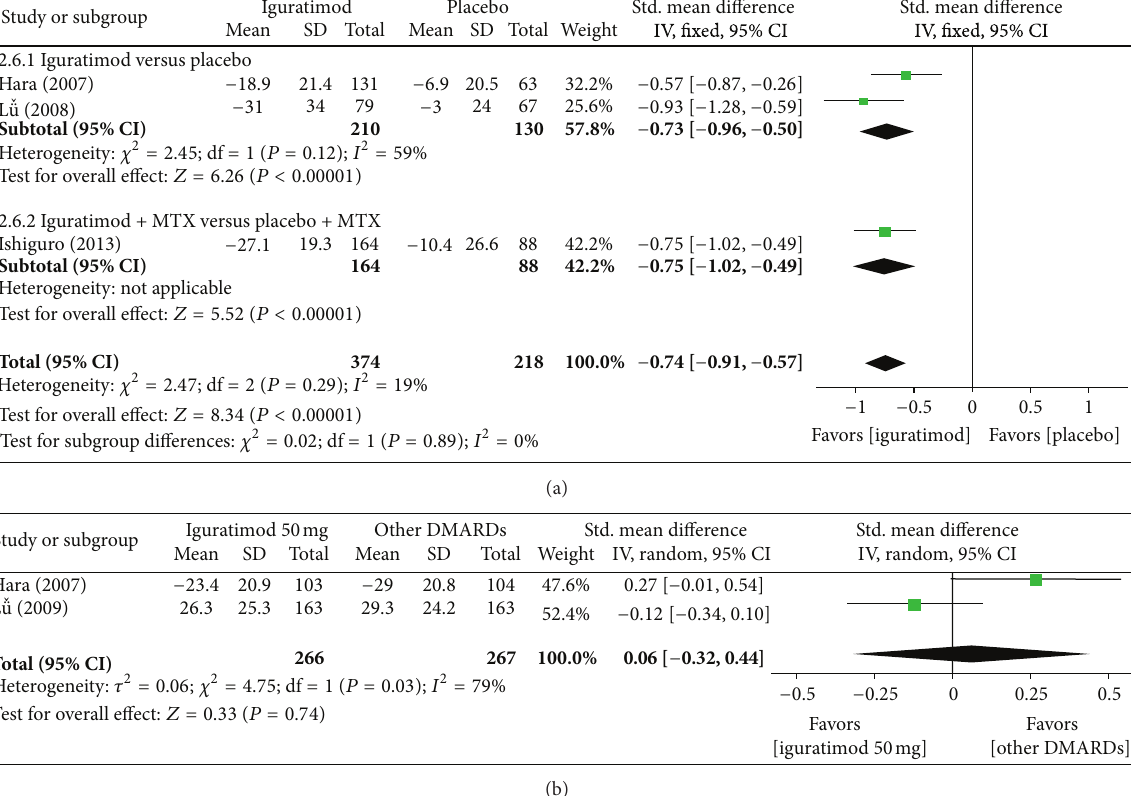
not be reached via email. Thus, low risk of performance bias and detection bias of outcome assessment